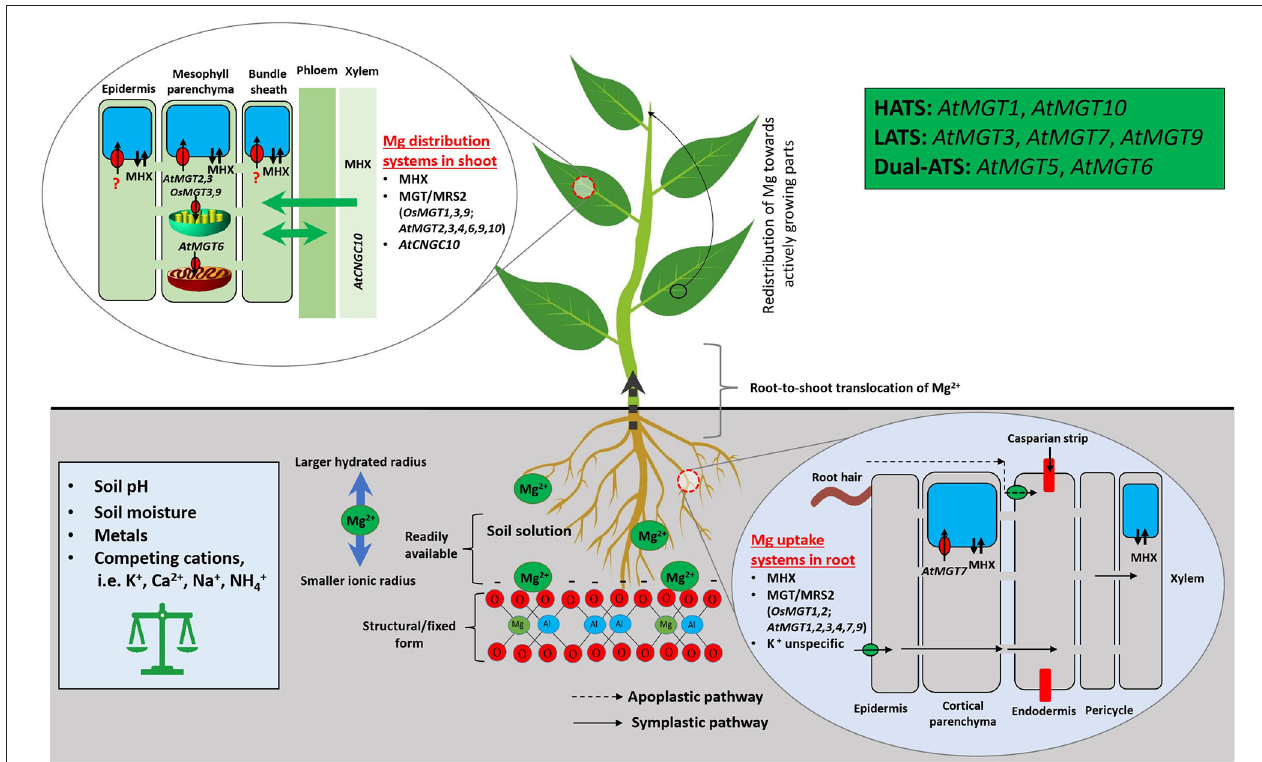
FIGURE 3 | Mg uptake, transport, and homeostasis in model plants Arabidopsis and rice. Mg 2 + absorption from the soil by plants is affected by a range of intrinsic and extrinsic factors. In soil, Mg 2 + is susceptible to leaching due to its larger hydrated and smaller ionic radius. Once the Mg 2 + reached the root surface, plants acquire it via CorA/MRS2/MGT, unspecific K-transporters, and MHX; using such transporters/exchanger, Mg 2 + enters into root epidermis, cortex, and then to the xylem after passing through the Casparian strip. The symplastic route depicts Mg movement from cell to cell, whereas, apoplastic refers to movement through extracellular spaces. Followed by, it transfers to shoot and leaves through xylem and stores in vacuole via specific transporters/exchanger. MGT/MRS2, Magnesium Transporters; MHX, Mg 2 + /H + Exchanger; MRS, Mitochondrial RNA Splicing; HATS, High-Affinity Transport System; LATS, Low-Affinity Transport System; Dual-ATS, Dual-Affinity Transport